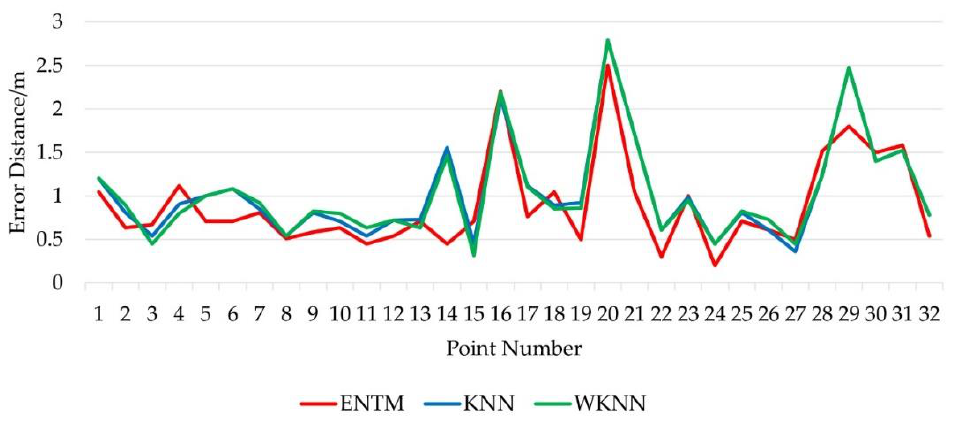
Figure 11. Comparison of the locating error of each testing point.